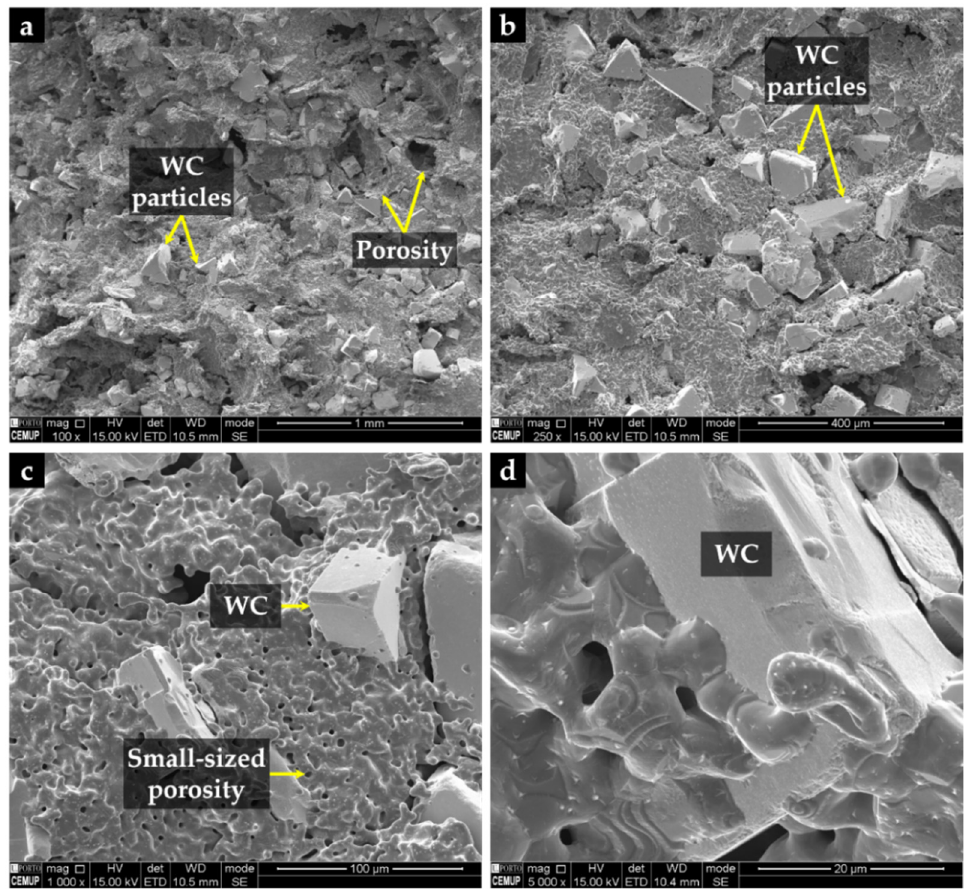
Figure 7. SEM-SE images of the surface of the porous sintered Fe–WC inserts: ( a ) Fe matrix with large WC particles and random porosity, ( b ) large polygonal-shaped WC particles with higher magnification, ( c ) small-sized porosity, and ( d ) wetting of a large WC particle by the iron.